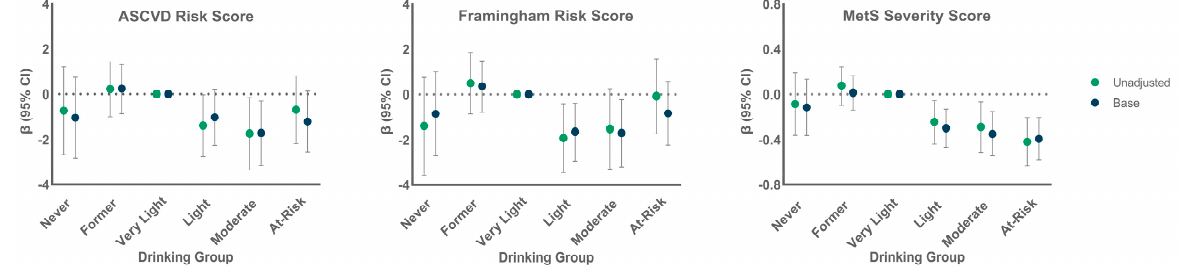
Figure 1. Unadjusted and base model β (95% CI) by drinking group comparing all groups to the very light drinking group for each of the three CVD risk scores.